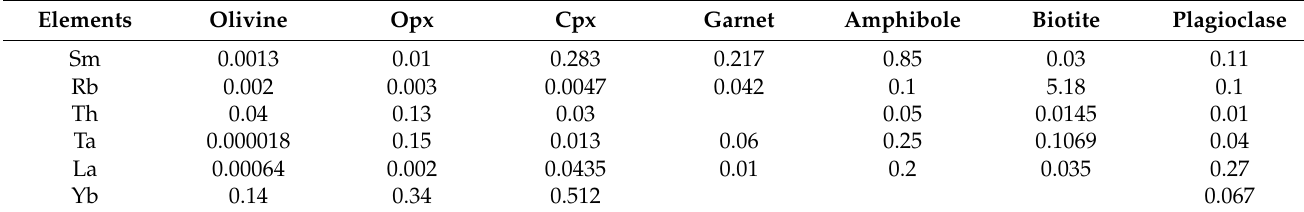
Table 4. Partition coefficients used in FC, AFC and melting models